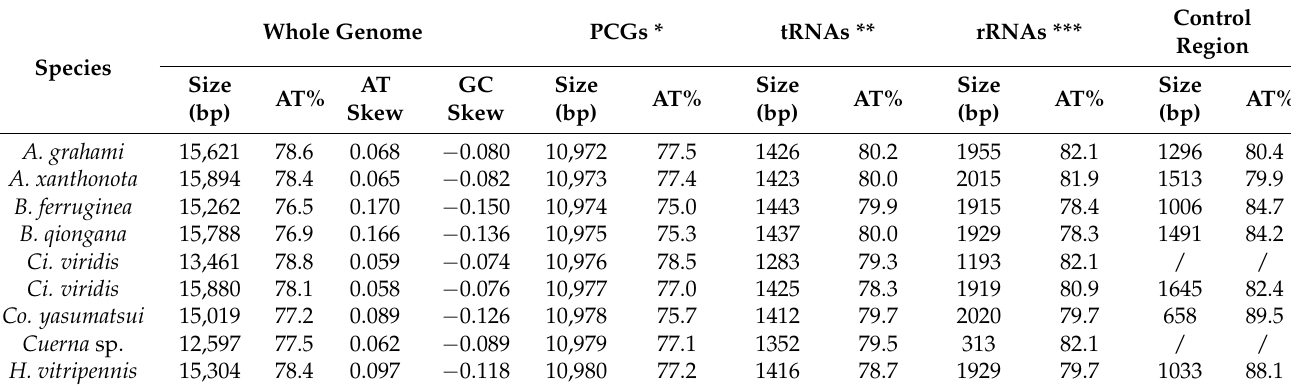
Table 5. Nucleotide composition of the Cicadellinae mitochondrial genomes of Atkinsoniella grahami , Atkinsoniella xanthonota , Bothrogonia ferruginea , Bothrogonia qiongana , Cicadella viridis , Cofana yasumatsui , Cuerna sp., and Homalodisca vitripennis .